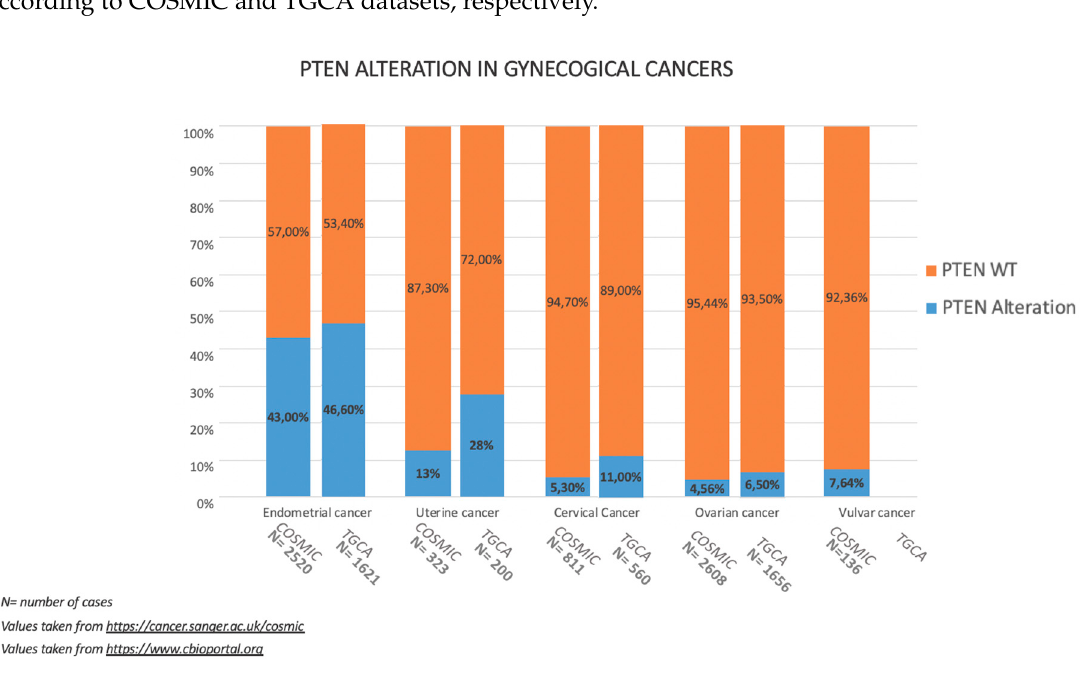
Figure 1. The incidence and type of PTEN alterations according to COSMIC and TGCA datasets in gynecological malignancies.